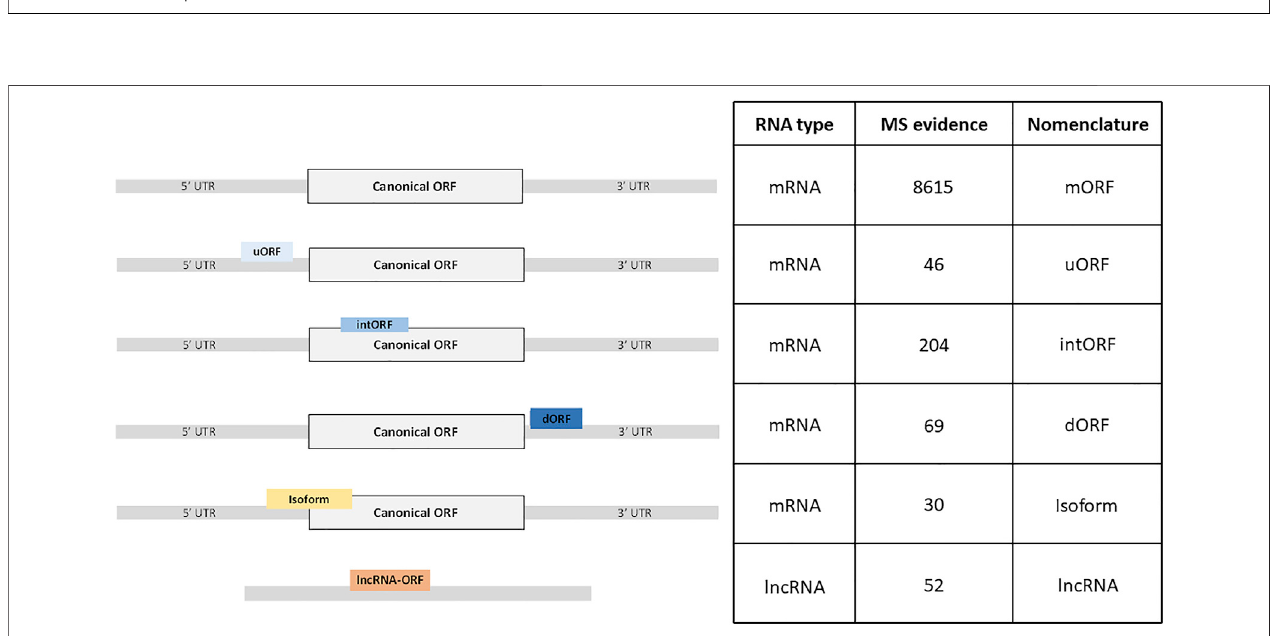
FIGURE1| Peptidomicswork fl owtoidentifyalternativeproteinsin Drosophilamelanogaster .Proteinswereextractedfromembryos,adult fl ies,orS2culturedcells using different extraction protocols. Alternative proteins were then enriched from the total protein pool and digested with trypsin (or other enzymes). The resulting peptideswereinjected ondifferent massspectrometry platformsand thegeneratedMSdata, aswell asdatasetsavailablefrom public repositories, wereanalyzed using MaxQuant with the OpenProt database.